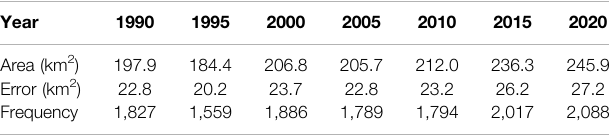
TABLE 4 | Changes in glacial lake area and frequency in the YZRB between 1990 and